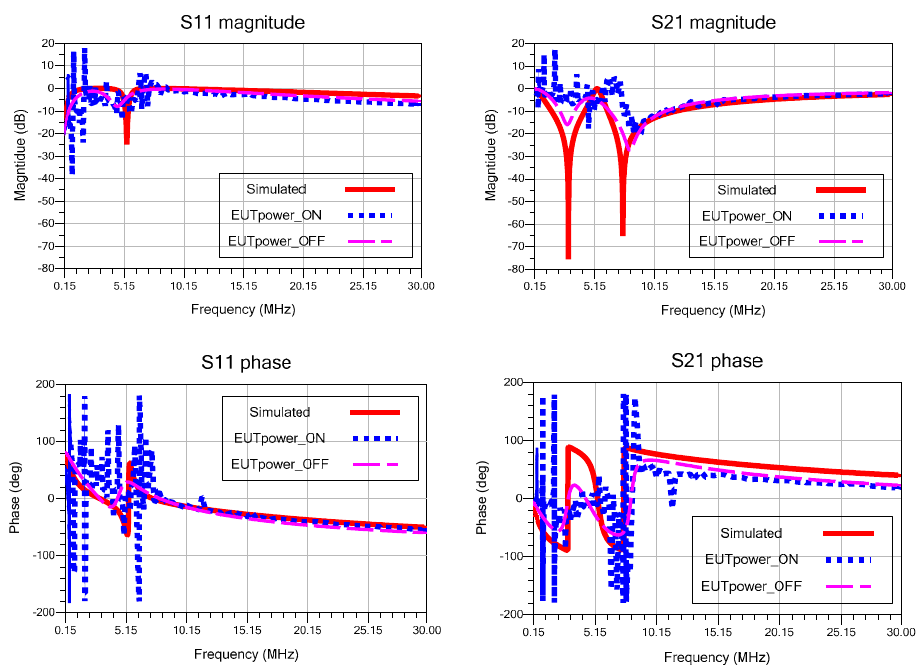
Figure 12. Comparison of the S-parameters obtained by simulations (red), EUT not powered (pink), and EUT powered (blue) for the SEPIC Converter Model MCP1663 after removing C IN .